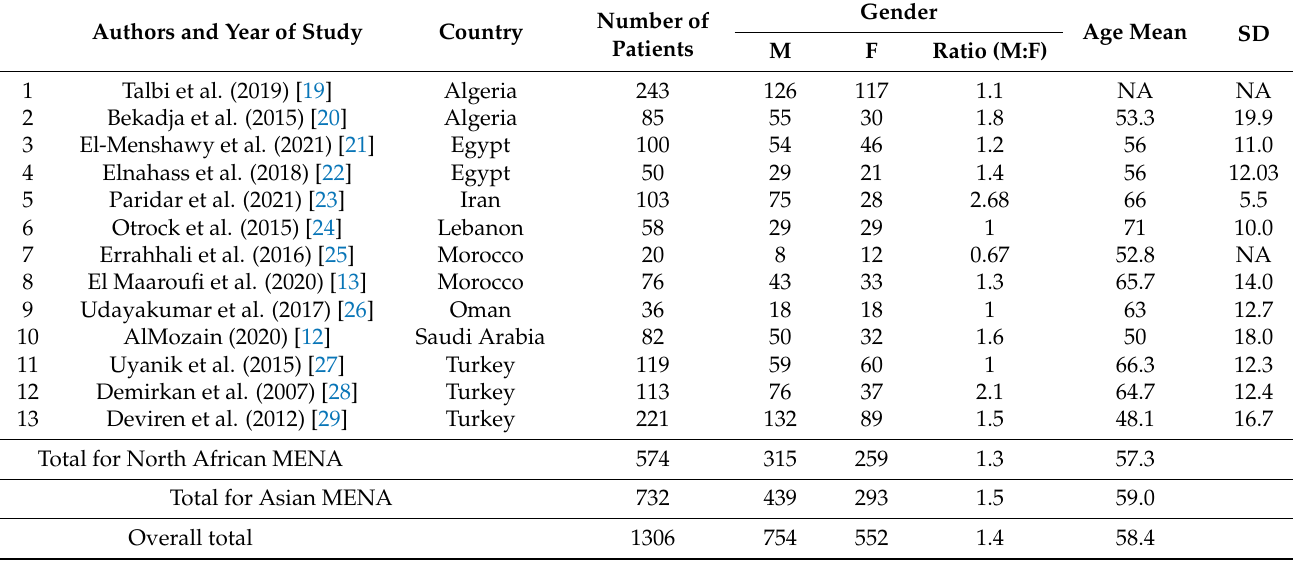
Table 2. Descriptive characteristics of the included studies (MDS = myelodysplastic syndrome, M = male, F = female, SD = standard deviation, NA = not available).